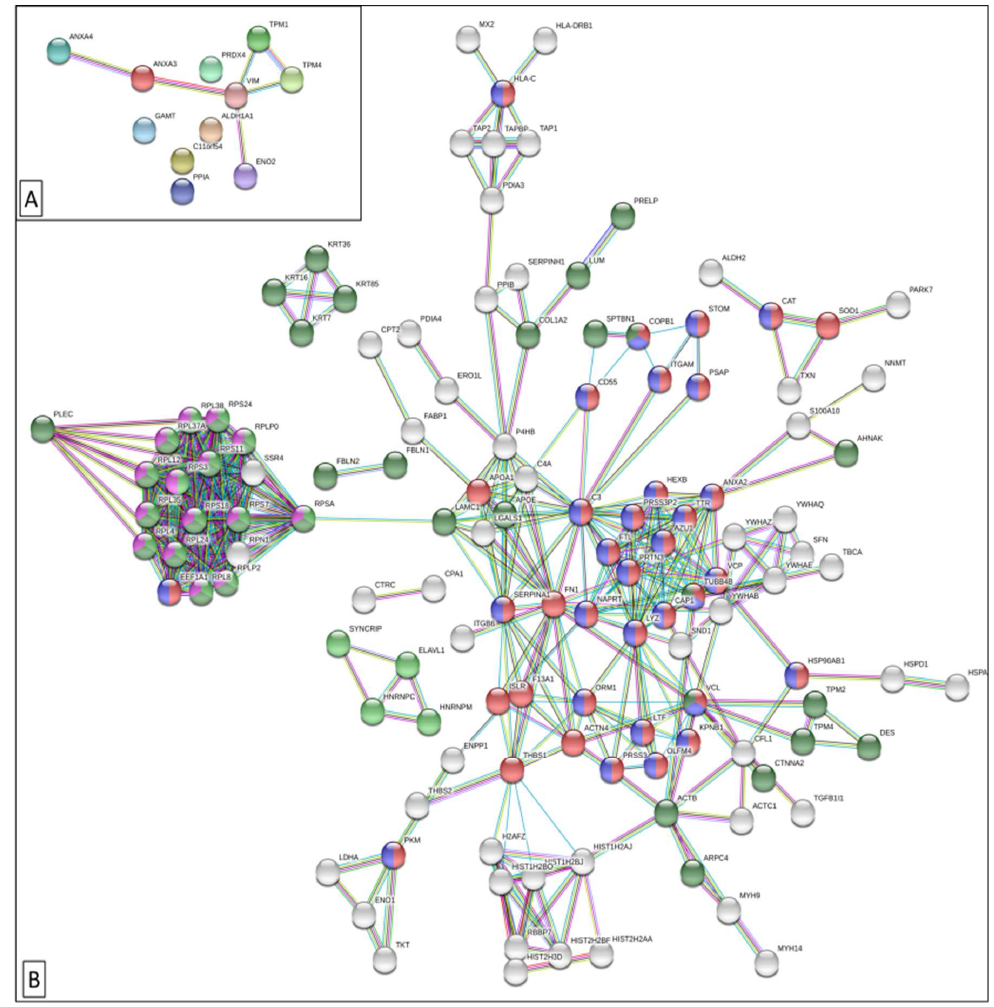
Figure 1. Protein functional interactome network for differentially expressed proteins identified in Pancreatic ductal adenocarcinoma (PDAC) tissue; down-regulated proteins ( A ) and up-regulated proteins ( B